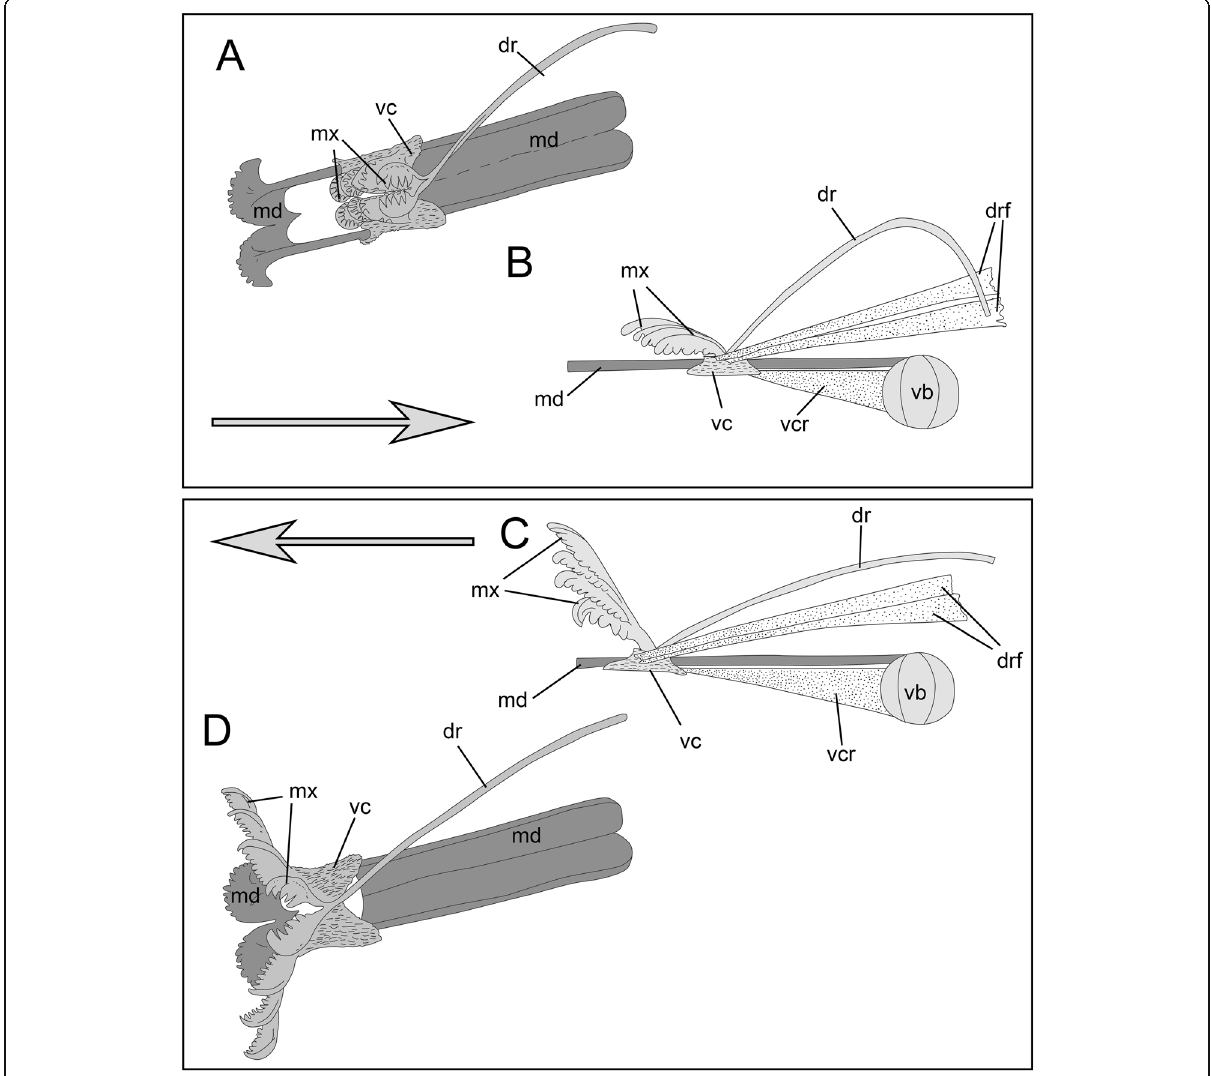
Fig. 12 Scheme of the jaw movement of Histriobdella homari . Putative function of the dorsal rod and associated muscular elements of the VPO during the retraction ( a , b ) and protraction ( c , d ) of the maxillae. The arrows indicate the direction of movement. dr, dorsal rod; drf, dorsal rod flexor; md, mandible; md, mandibles; mx, maxillae; vb, ventral muscular bulb; vc, ventral carriers; vcr, ventral carrier